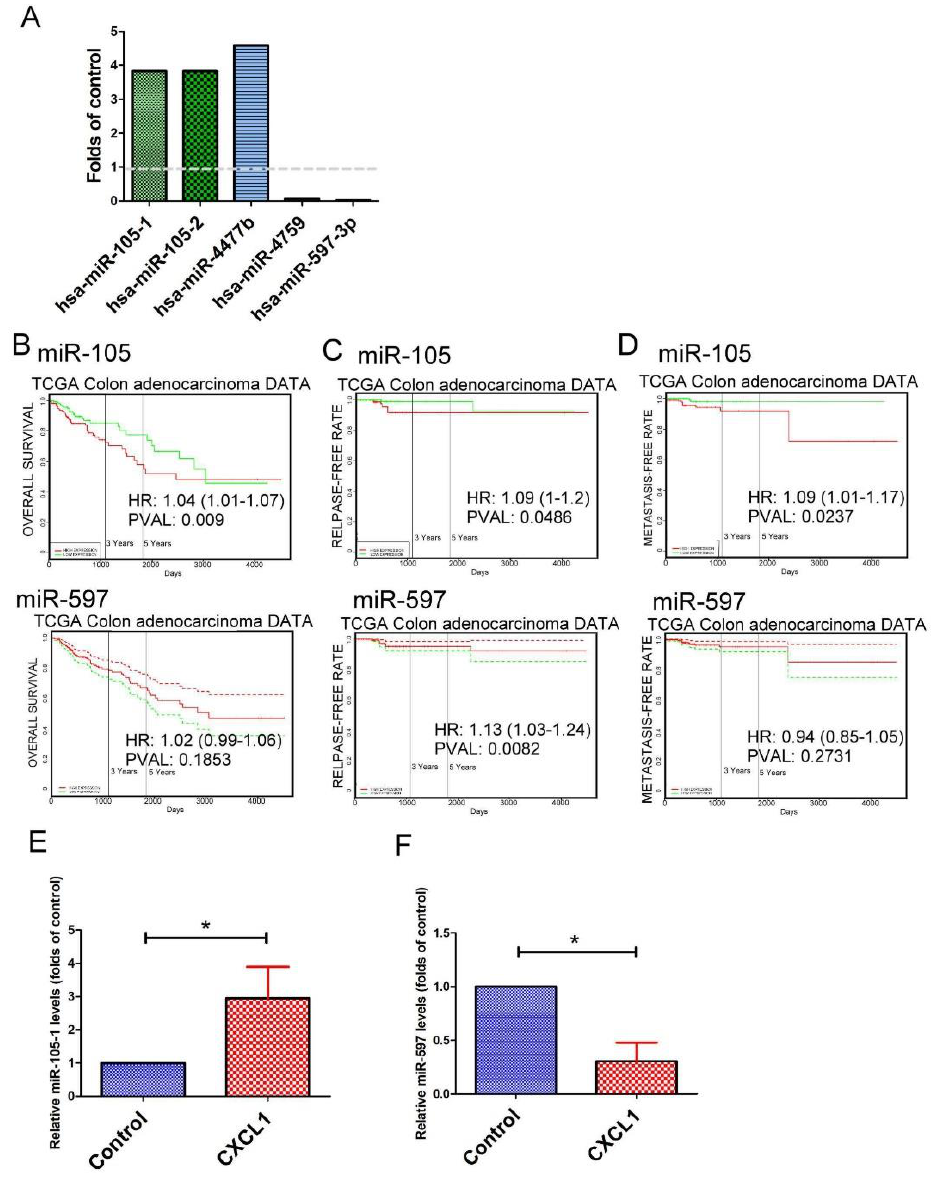
Figure 6. The effect of CXCL1 on the expression of microRNAs (miRNAs) in colon cancer. ( A ) The regulatory effect of CXCL1 on the expressions of miRNAs in colon cancer. Prognostic significance of miR-105 and miR-597 in overall survival ( B ), relapse-free ( C ) and metastasis-free rates ( D ) in colon cancer patients. The effect of CXCL1 on the levels of miR-105 ( E ) and miR-597 ( F ) in colon cancer. SW620 cells were treated with CXCL1 for 24 h, and the expression of miR-105 and miR-597 determined by qRT-PCR. Each value is the mean ± SD of three determinations. * Significant difference between the two test groups ( p < 0.05) (*). Hsa, Homo sapiens; TCGA, The Cancer Genome Atlas; HR, hazard ratio; PVAL, p -value.